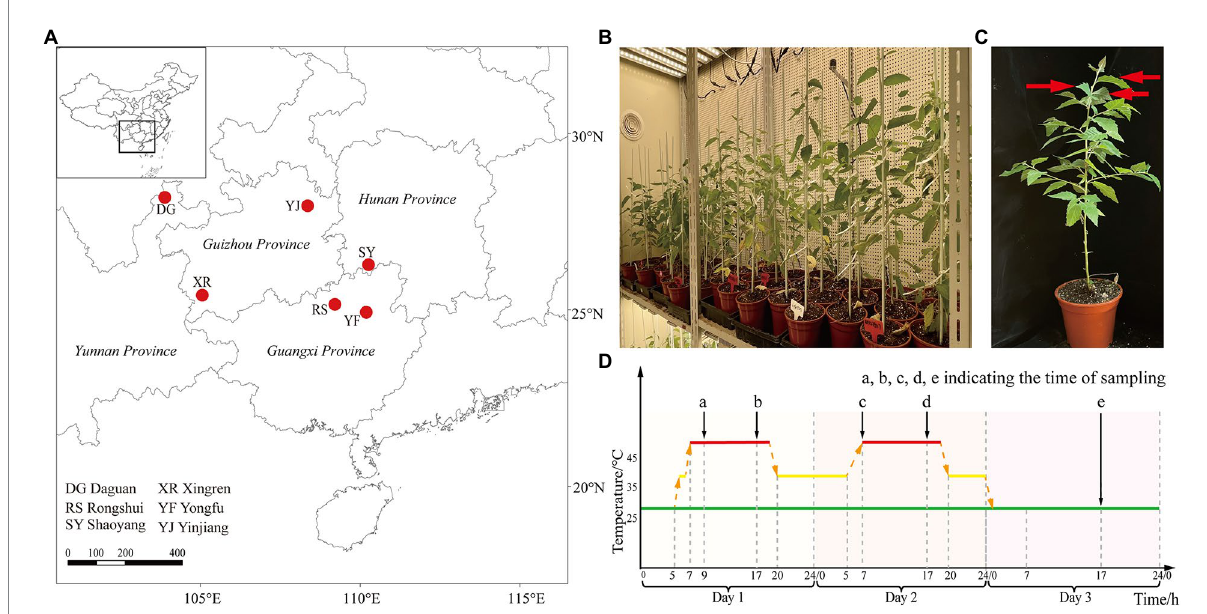
FIGURE 1 Plant material and experimental design. (A) The provenance locations of B. luminifera populations. (B) The growth chambers for the light/dark regime in heat stress treatment. (C) Sampling locations. Red arrows indicate sampling location. (D) Schematic diagram of the heat stress experimental design. The red line indicates the timeline of heat treatment, the green solid line indicates room temperature, and the black arrows (a, b, c, d, and e) indicate the time of